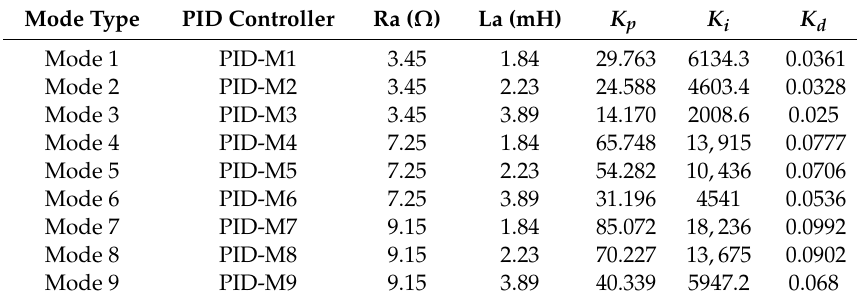
Table 3. Determination of PID controller parameters for the DC motor by using the root locus